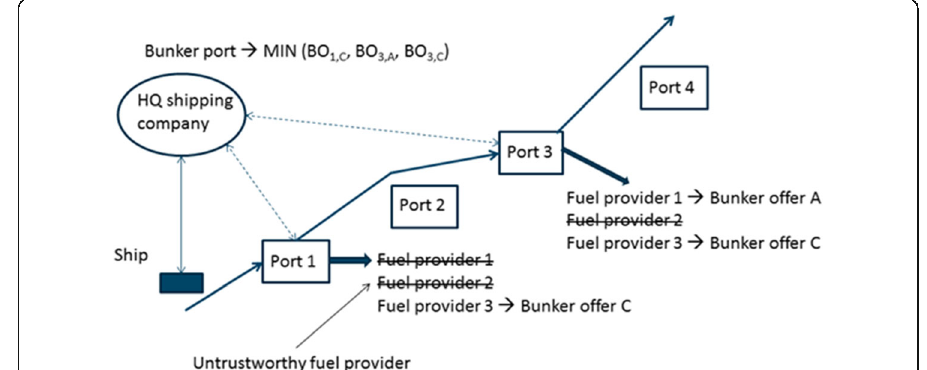
Fig. 2 Bunkering selection process. Source: own